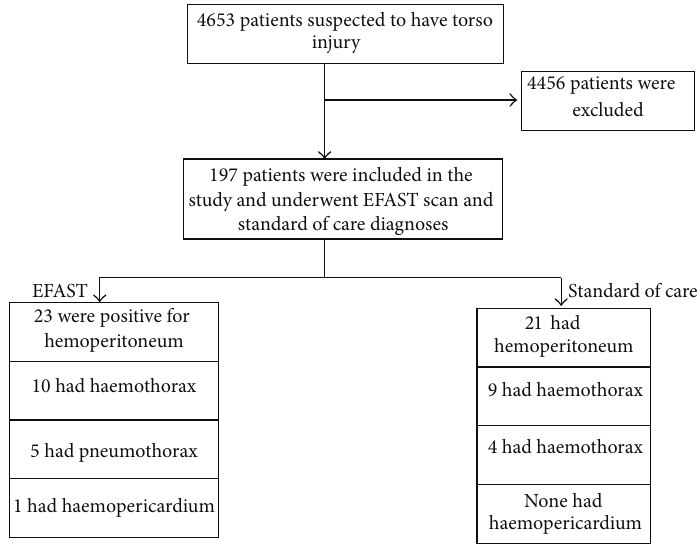
Figure 1: Study for the emergency ultrasound scan torso trauma Uganda study,